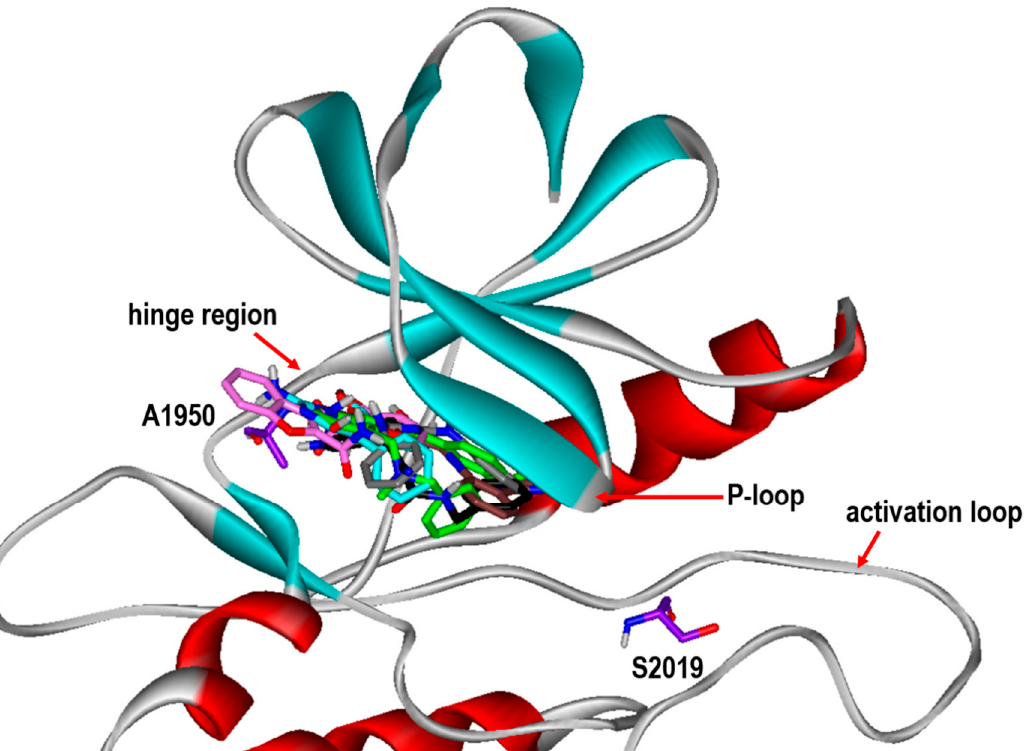
Figure 5. Comparative view of the binding modes of Inhibitors 1-6 in the ATP-binding sites of the G2019S mutant of LRRK2. The carbon atoms of LRRK2 and Inhibitors 1-6 are indicated in violet, green, cyan, black, gray, pink, and brown, respectively. The positions of Ala1950 in the hinge region and mutated Ser2019 are also indicated.